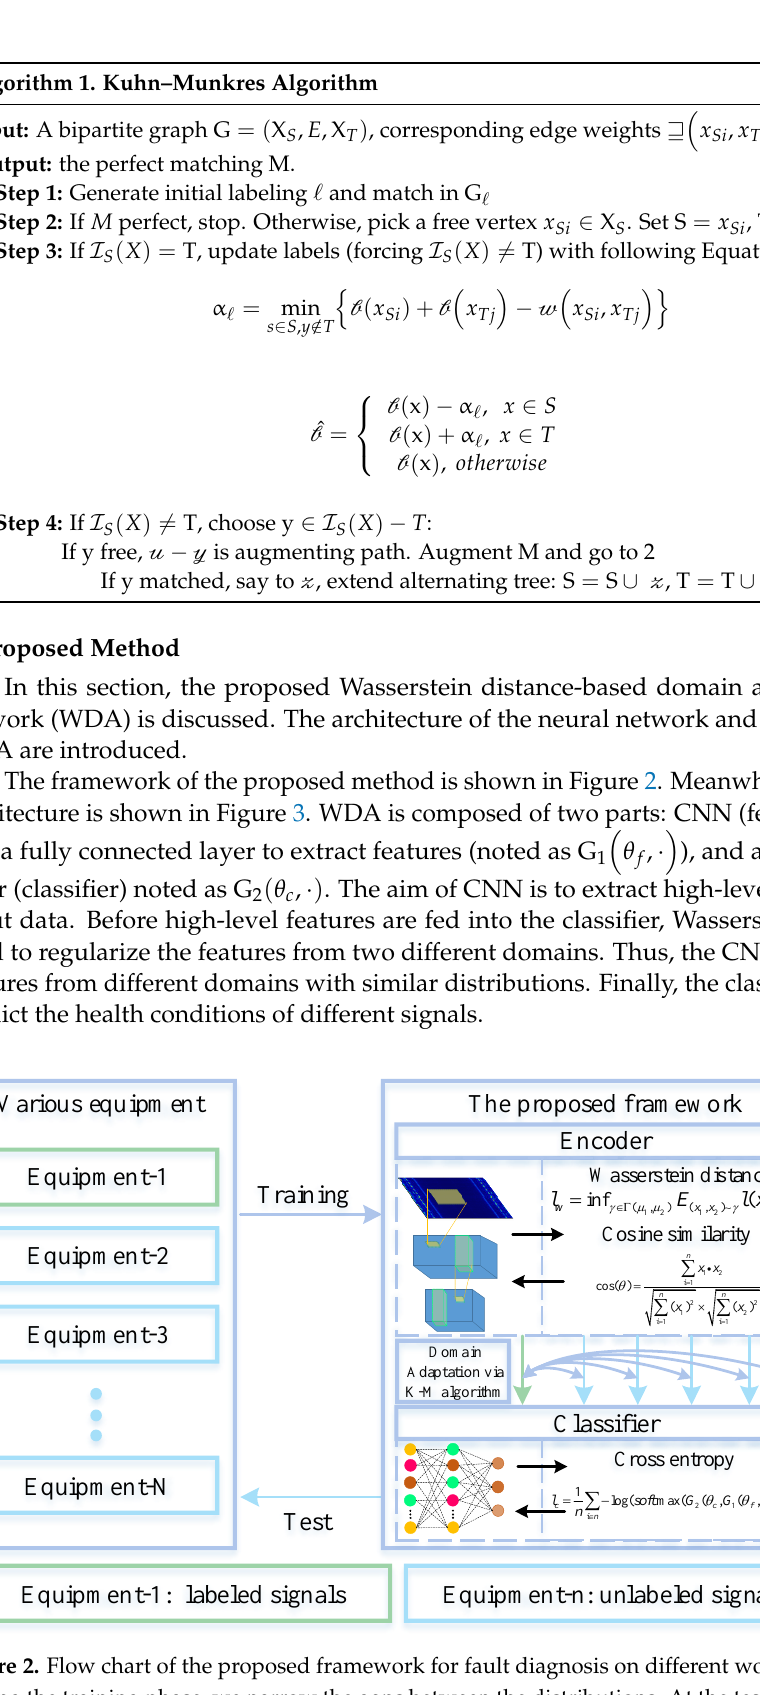
Figure 3. The architecture of the proposed WDA. In the testing phase, the feature maps from the target domain are directly fed into the classifier. 3.1. Network Architecture The architecture of WDA is shown in Figure 4. It contains two parts: feature extractor and fully connected classifier. Figure 4. Architecture of WDA.